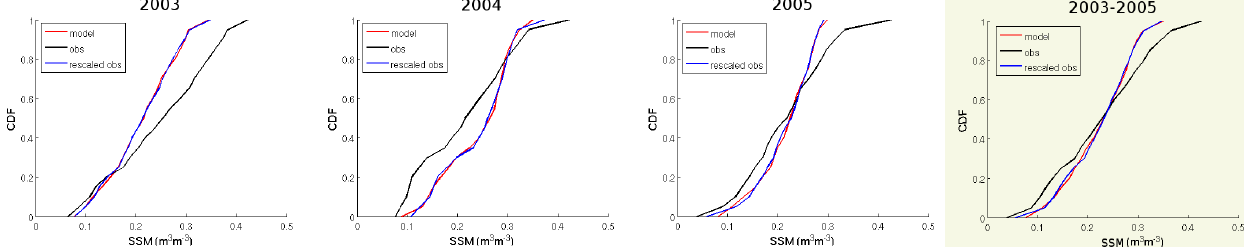
Fig. 11. Difference of the Kalman gain provided by the SSM assimilation in DF-B and DF-REF. Soil layer depths (in cm) are represented on the left-hand side y axis and time is represented on the x axis.